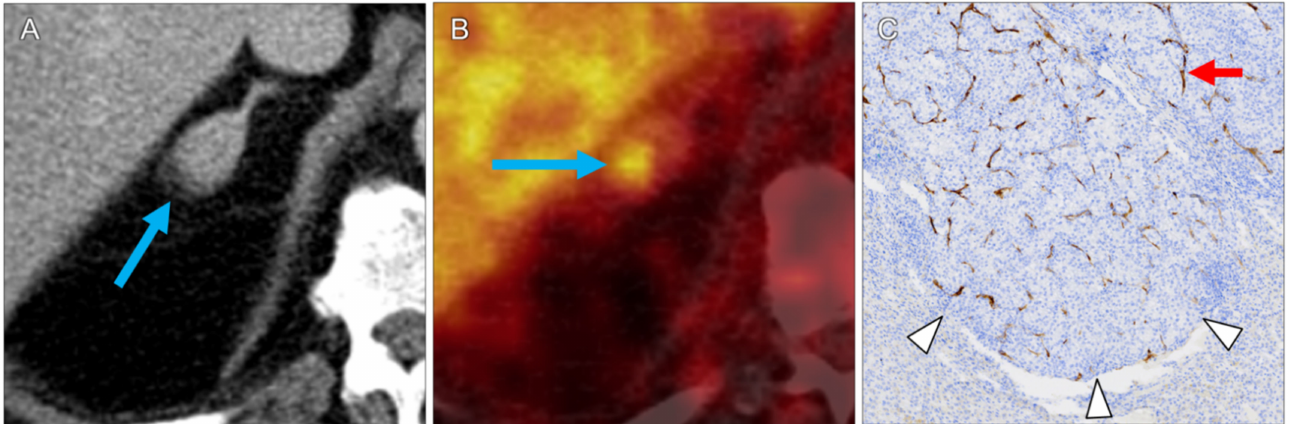
Figure 3. RCC metastasis in the right adrenal gland (lesion 11). Contrast-enhanced CT shows enlargement of the gland (( A ), arrow). On PET, tracer uptake is highest in its posterior part (( B ), arrow; SUVmax 7.7). Histology shows invading tumor tissue (( C ), arrowheads). The brown structures (( C ), arrow) represent microvascular PSMA expression, which is not seen in the glandular tissue itself.